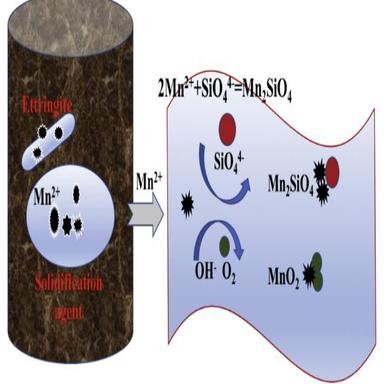
S/S mechanism diagram.